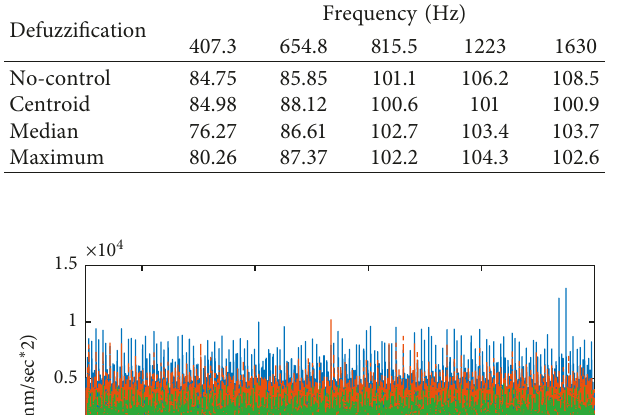
Table 5: The amplitudes of the vibration of the gear system at the main frequencies.